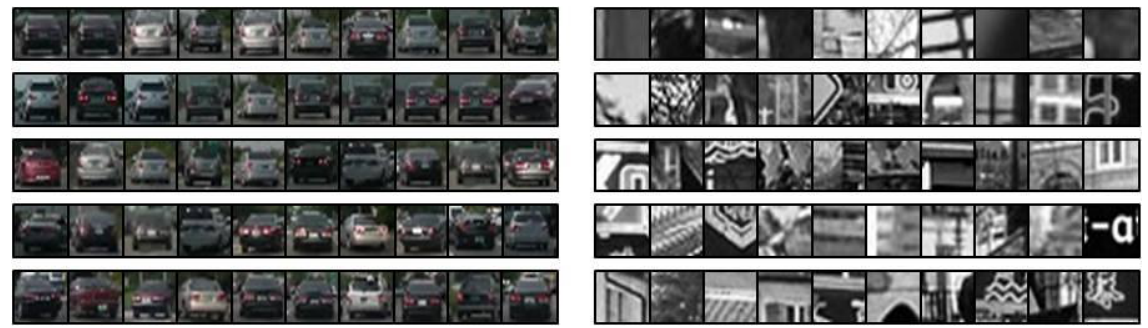
Figure 5. Example of the rear-of-car images ( left ) and the non-car images ( right ) used for